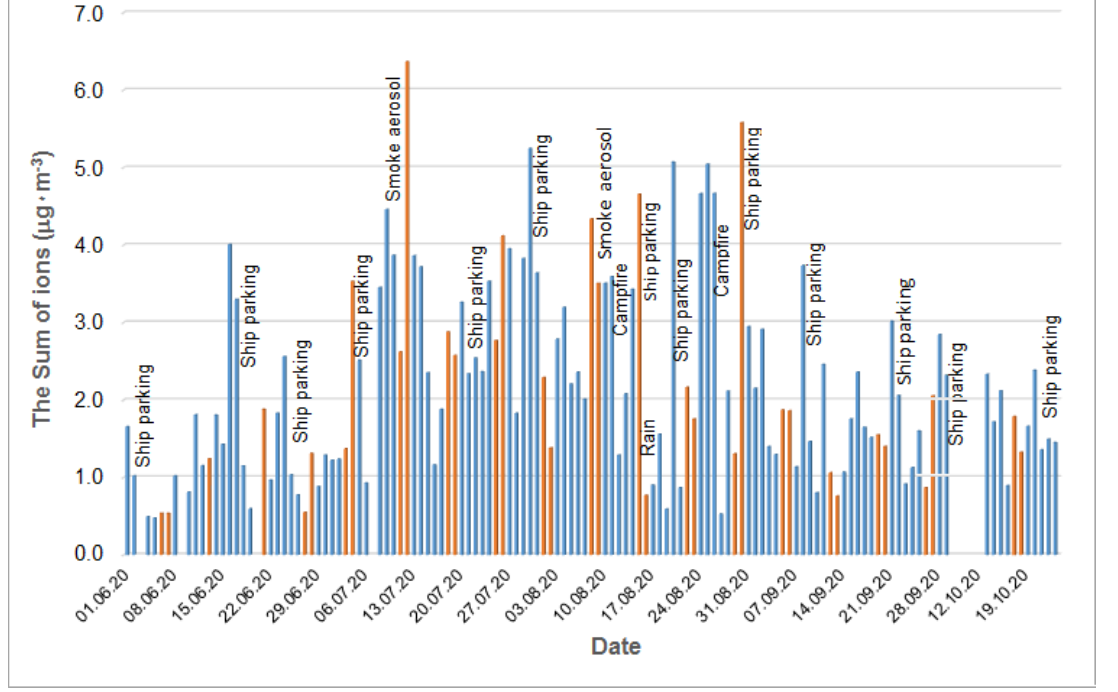
Figure 3. Dynamics of the total ionic concentration in aerosol at the Bolshiye Koty research station in 2020, μg/m 3 . Brown columns — Saturday, Sunday.